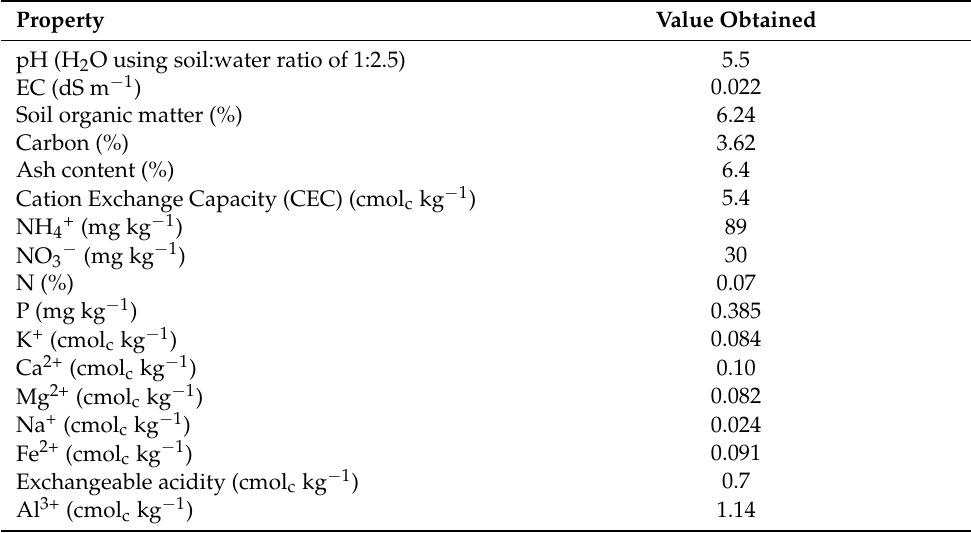
Table 1. Selected soil chemical